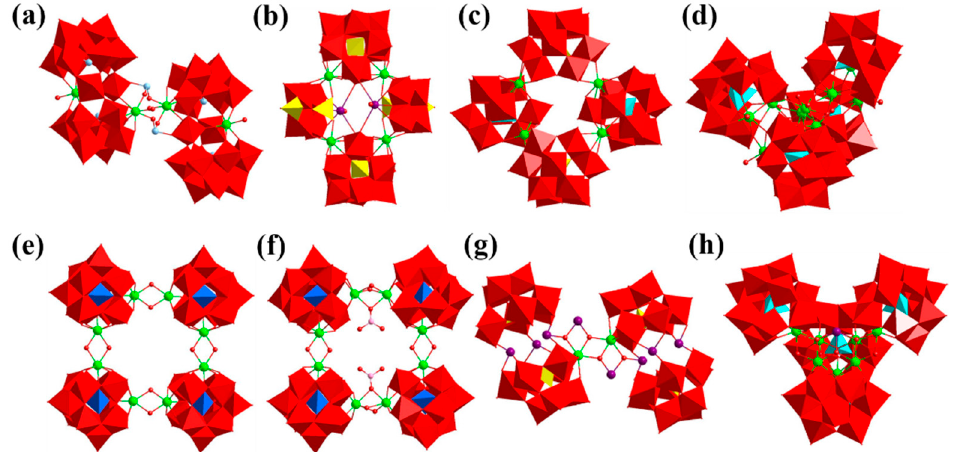
Figure 7. The ball-and-stick and polyhedral illustration of ( a ) [( α -SeW 9 O 34 ){Zr(H 2 O)}{WO(H 2 O)}(WO 2 )(SeO 3 ){ α -SeW 8 O 31 Zr(H 2 O)}] 212 − polyoxoanion, ( b ) {Zr 2 [SbP 2 W 4 (OH) 2 O 21 ][ α 2 -PW 10 O 38 ]} 220 − polyoxoanion, ( c ) [Zr 4 ( β -GeW 10 O 38 ) 2 (A- α -PW 9 O 34 ) 2 ] 26 − polyoxoanion; ( d ) [{Zr 5 ( µ 3 -OH) 4 (OH) 2 }@{Zr 2 (OAc) 2 ( α -GeW 10 O 38 ) 2 } 2 ] 22 − polyoxoanion, ( e ) [{Zr 2 (OH) 2 ( α -SiW 10 O 38 )} 2 {Zr 2 (OH) 2 ( β -SiW 10 O 38 )} 2 ] 24 − polyoxoanion, ( f ) [(Zr 2 (OH) 2 ) 2 (Zr 2 BO(OH) 4 ) 2 ( β -SiW 10 O 38 ) 4 ] 26 − polyoxoanion, ( g ) [ZrSb 4 (OH)O 2 (A- α -PW 8 O 32 )(A- α -PW 9 O 34 )] 218 − polyanion and ( h ) [SbZr 7 O 6 (OH) 4 (B- α - GeW 9 O 34 ) 2 (B- α -GeW 11 O 39 ) 2 ] 21 − polyoxoanion. Color codes: WO 6 , red; PO 4 , yellow; SiO 4 , light blue; GeO 4 , turquoise; Se, pale blue; Sb, violet; Zr, bright green; B, rose; O,